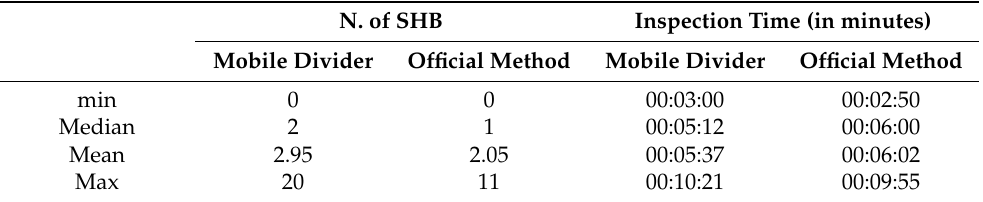
Table 5. Summary results of the number of A. tumida detected and inspection time